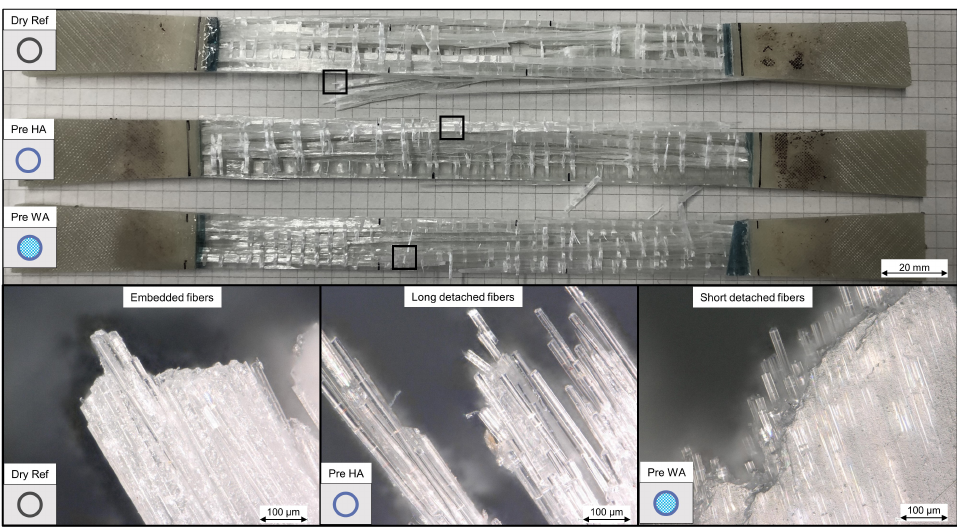
Figure 12. Macroscopic images of specimens after fatigue testing ( top ) and microscopic images of broken fiber bundles from specimens (black squares) in relation to different (pre)conditions ( bottom